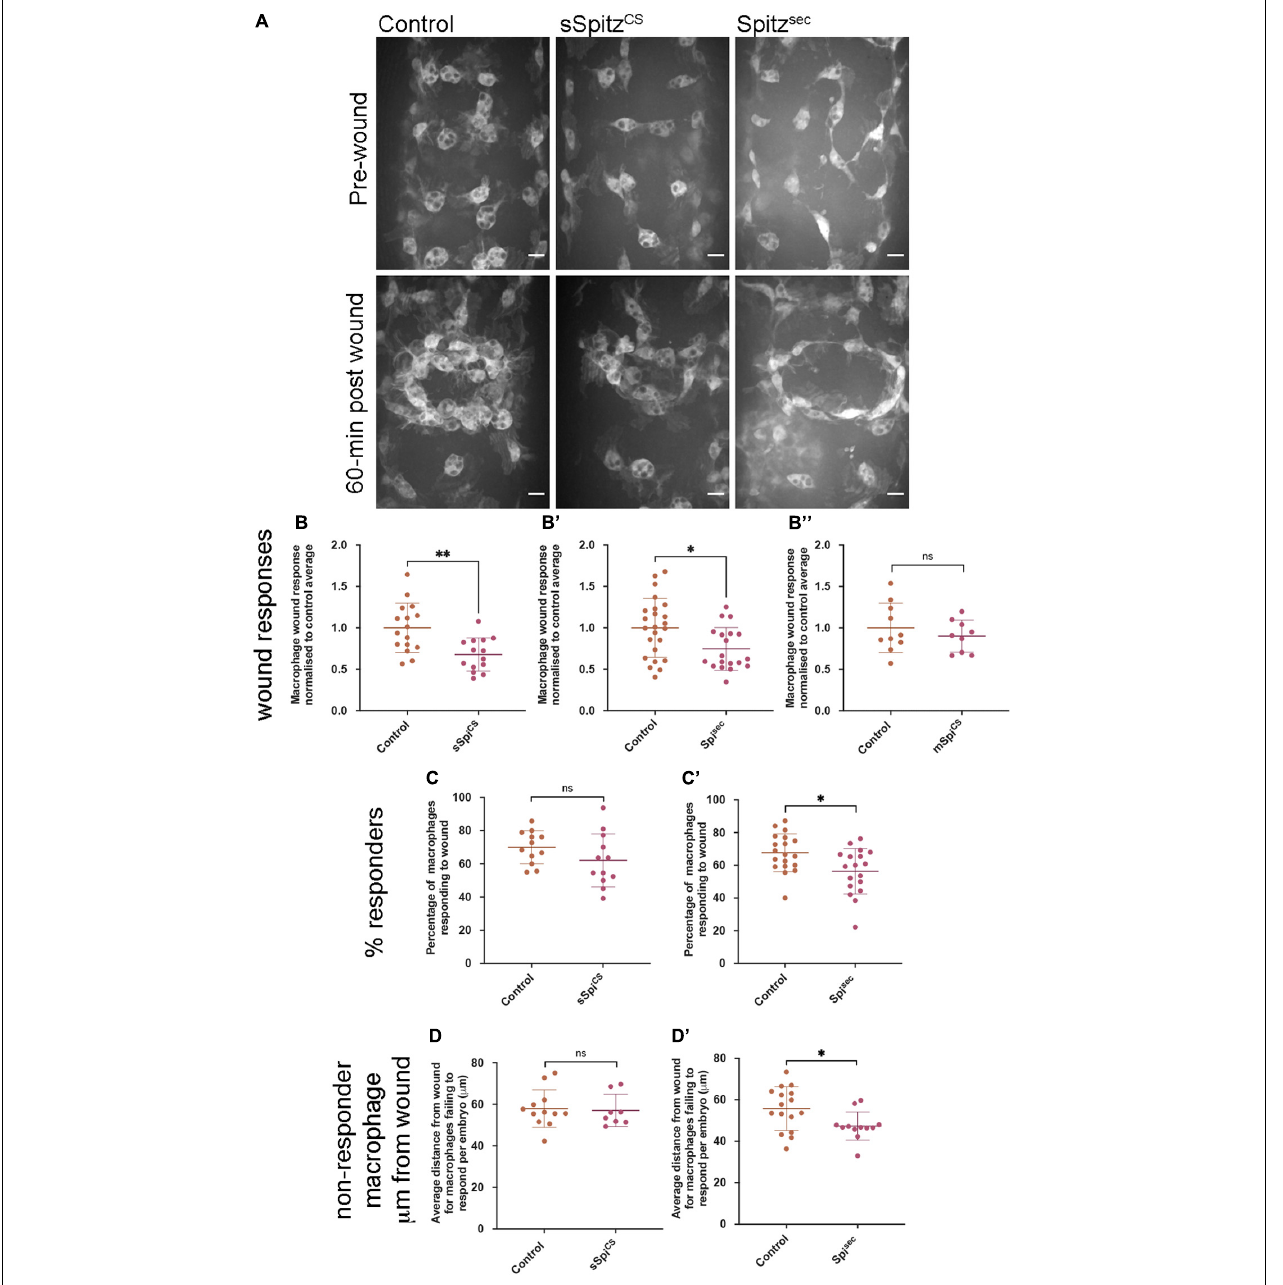
FIGURE 5 | Spitz impairs macrophage wound responses. (A) Maximum projections showing images of GFP-labeled macrophages on the ventral midline region in controls and in embryos containing macrophages expressing sSpitz CS or Spitz sec ; upper panels show stage 15 embryos immediately prior to wounding; lower panels show corresponding embryo 1-h post wounding. (B–B (cid:48)(cid:48) ) Scattergraphs showing macrophage wound responses (number of macrophages responding to the wound normalized to wound area and to control responses) in controls and embryos with macrophage-specific expression of sSpitz CS (B) ( n = 16, 14; p = 0.0020), Spitz sec (B (cid:48) ) ( n = 24, 19; p = 0.0160), or mSpitz CS ( n = 9, 10; p = 0.406). (C,C (cid:48) ) Scattergraphs showing percentage of macrophages responding to wound per embryo (% of those in the field of view that reach the wound) per embryo for control embryos compared to embryos with macrophage specific-expression of sSpitz CS (C) ( n = 12, 12; p = 0.159) or Spitz sec (C (cid:48) ) ( n = 19, 18; p = 0.0105). (D,D (cid:48) ) Scattergraphs showing average distance from the wound edge (immediately prior to wounding) of those macrophages that fail to respond, per embryo, for control embryos compared to embryos with macrophage specific-expression of sSpitz CS (D) ( n = 12, 8; p = 0.678) or Spitz sec (D (cid:48) ) ( n = 16, 12; p = 0.0421). Scale bars denote 10 µ m; lines and error bars represent mean and standard deviation on scattergraphs, respectively; significance bars denote ns p > 0.05, ∗ p < 0.05, and ∗∗ p < 0.01, respectively; statistical comparisons made via a Mann–Whitney test (B (cid:48) ,B (cid:48)(cid:48) ,D,D (cid:48) ) or an unpaired, two-tailed Student’s t -test (B,C,C (cid:48) ) . Embryo genotypes are as follows: w; Srp-GAL4,UAS-GFP/ + ; Crq-GAL4,UAS-GFP/ + (Control) , w; Srp-GAL4,UAS-GFP/UAS-sSpitz CS ; Crq-GAL4,UAS-GFP/ + (sSpi CS ), w;Srp-GAL4,UAS-GFP/ + ; Crq-GAL4,UAS-GFP/UAS-Spitz Sec (Spi sec ) and w; Srp-GAL4,UAS-GFP/ + ; Crq-GAL4,UAS-GFP/UAS-mSpitz CS -GFP (mSpi CS ).